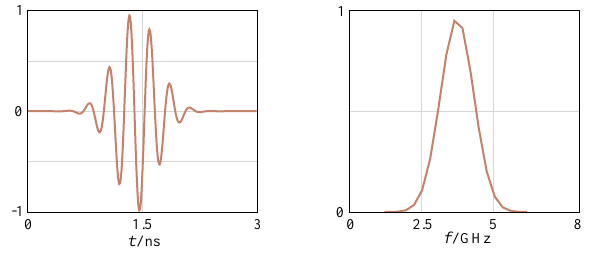
FIG. 4. (Color) Normalized time signal and DFT spectrum of the dipole waveguide mode as used for the excitation of the structure.